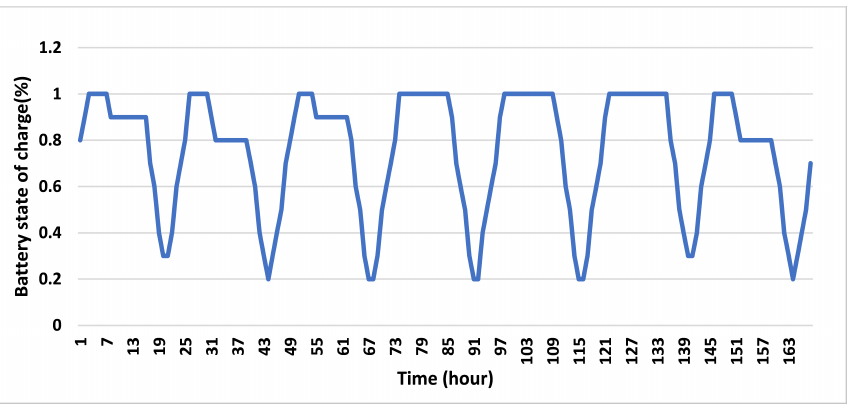
Figure 19. Battery state of charge during a week in the rainy season: Case 3, Scenario 1. The power outage occurred for two hours only during the year in this scenario. The outage began at 4 pm on 17 August and lasted for two hours. At that time, the DG covered the power shortage by contributing about 183